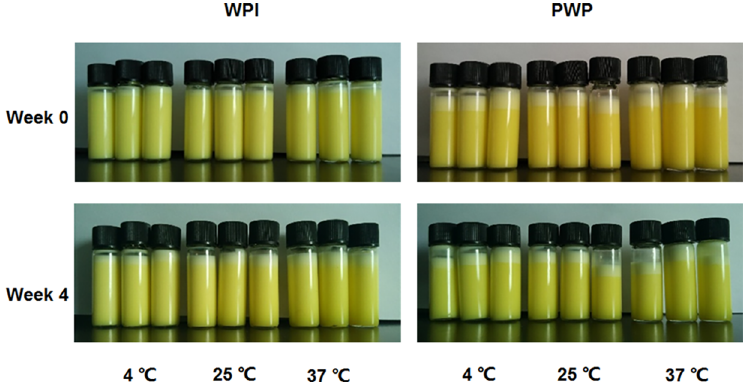
Fig 2. The stability of WPI or PWP based lutein emulsions at different temperatures during storage. PWP showed stratification within one week at all temperatures tested, whereas only WPI based lutein loaded emulsion was stable during four weeks’ storage at 4˚C. The WPI emulsion showed a little of stratification at 25˚C and